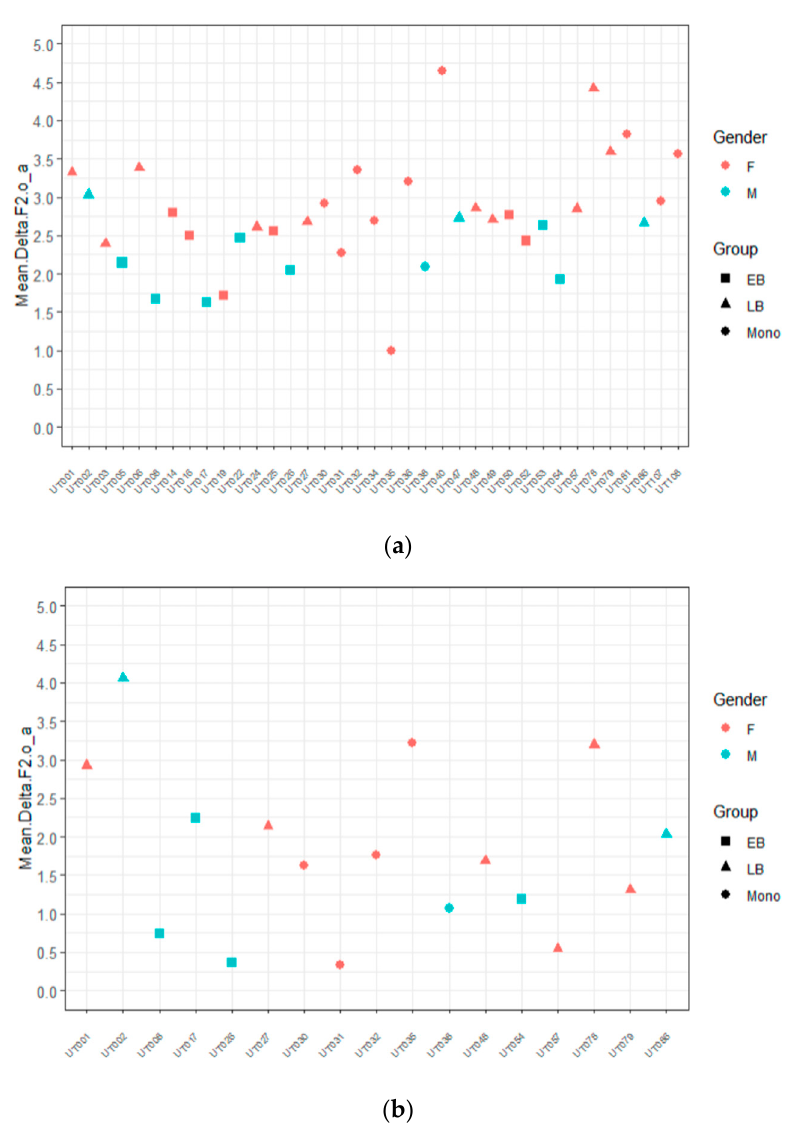
Figure 6. F2-F1 in Bark for the vowel /o/: ( a ) Values obtained for /o/ minus values obtained for /a/ in predictable contexts; ( b ) values obtained for /o/ minus values obtained for /a/ in non-predictable contexts.